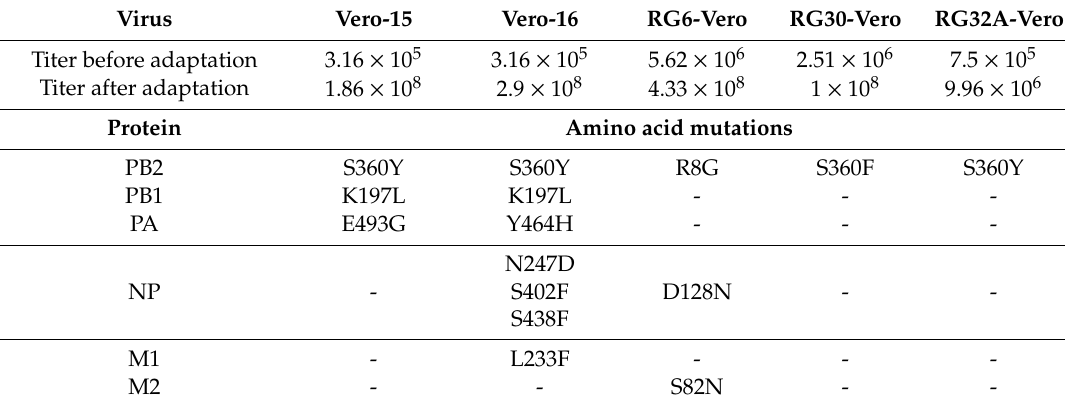
Table 1. Genomic analysis of Vero-adapted viruses. Vero-15, Vero-16: two Vero cell-derived high-growth viruses adapted from NIBRG-14. RG6-Vero: Vero-adapted IDCDC-RG6. RG30-Vero: